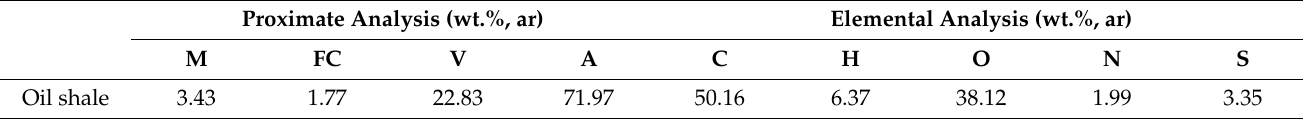
Table 1. Proximate and elemental analyses of oil shale. Proximate Analysis (wt.%,